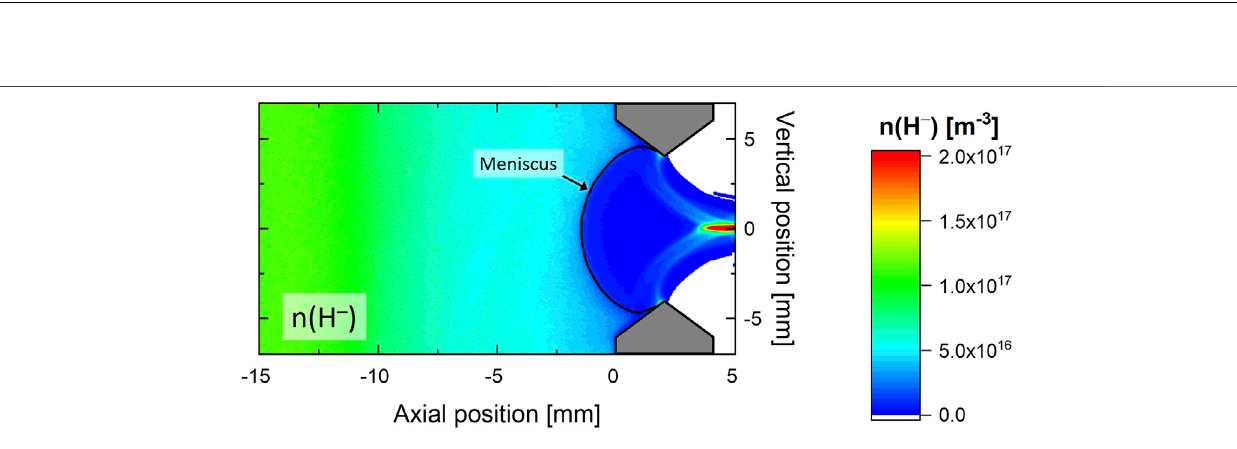
Frontiers in Physics |